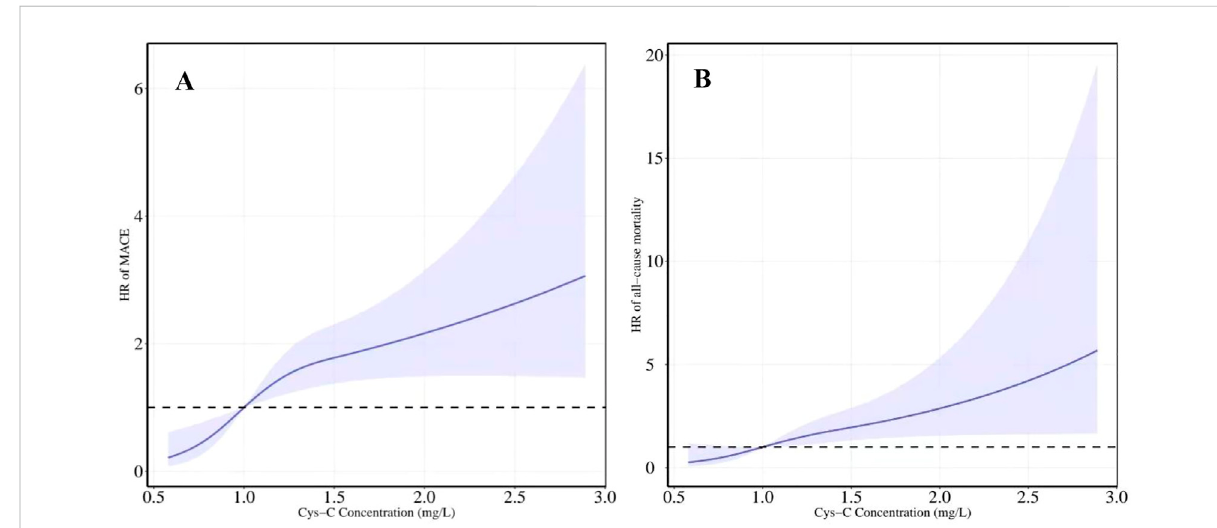
FIGURE 6 Restricted cubic spline regression model was conducted with three knots at the 10th, 50th, and 90th percentiles of Cys-C. The dotted lines represent the 95% con fi dence intervals for the spline model (reference is 1.0 mg/L). (A) HR for MACE according to levels of Cys-C on a continuous scale (B) HRfor all-cause mortality accordingto levels ofCys-Conacontinuous scale.Analyseswereadjustedfor age,sex,BMI,SBP,creatinine,uric acid,AHI,ODI,LSpO2,LAT,CHD,hypertension,hyperlipidemia,diabetes,atrial fi